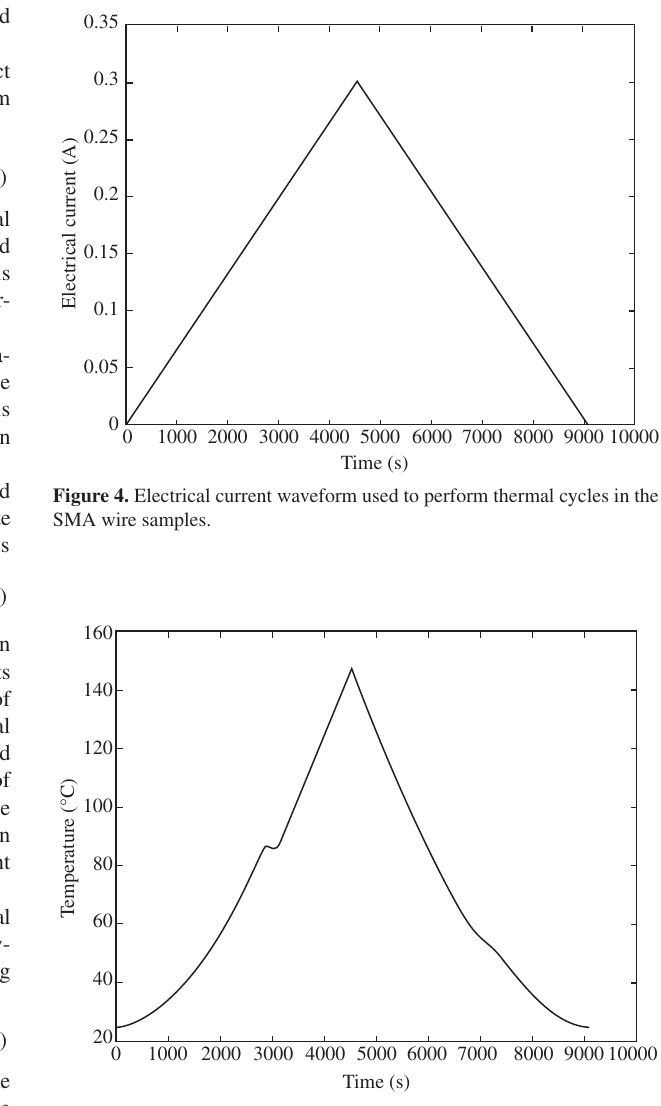
Figure 5. Temperature waveform estimated using Equation